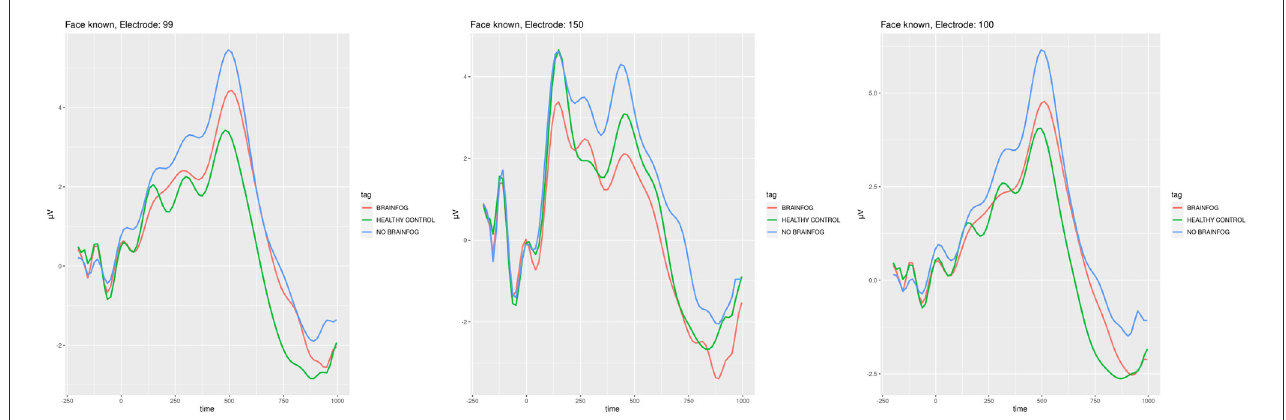
FIGURE4 ERP plots generated for the electrodes E99 , E150 , and E100 that showed smallest cross-correlation in the face recognition experiment when the participants saw the known face . Red line—the participants that suffered from COVID-19 and with brain fog symptoms. Blue line—the participants that suffered from COVID-19 and without brain fog symptoms. Green line—the participants without COVID-19 episode. See also Tables 3–5 in Appendix A.